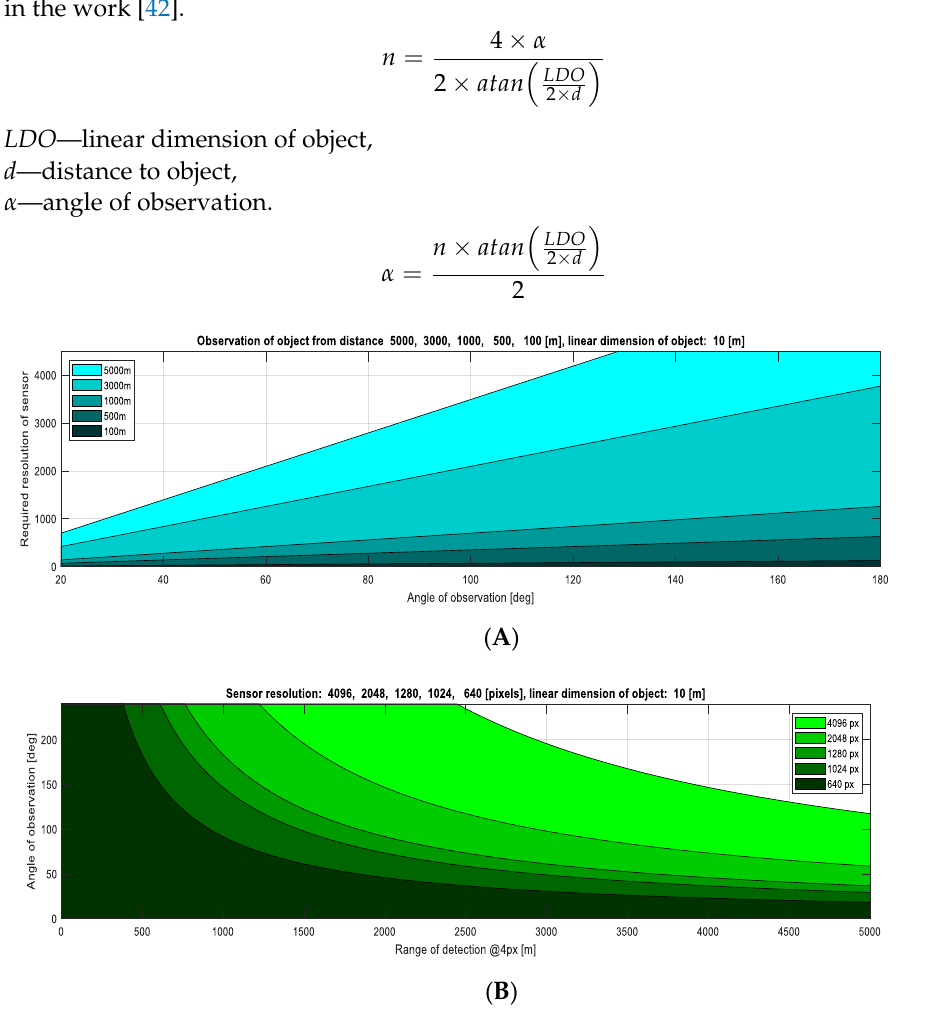
Figure 2. Dependence of sensor-required resolution on angle of observation and distance ( A ), and dependence on angle of observation on range of detection and resolution ( B ); simulations for linear dimension of object LDO = 10